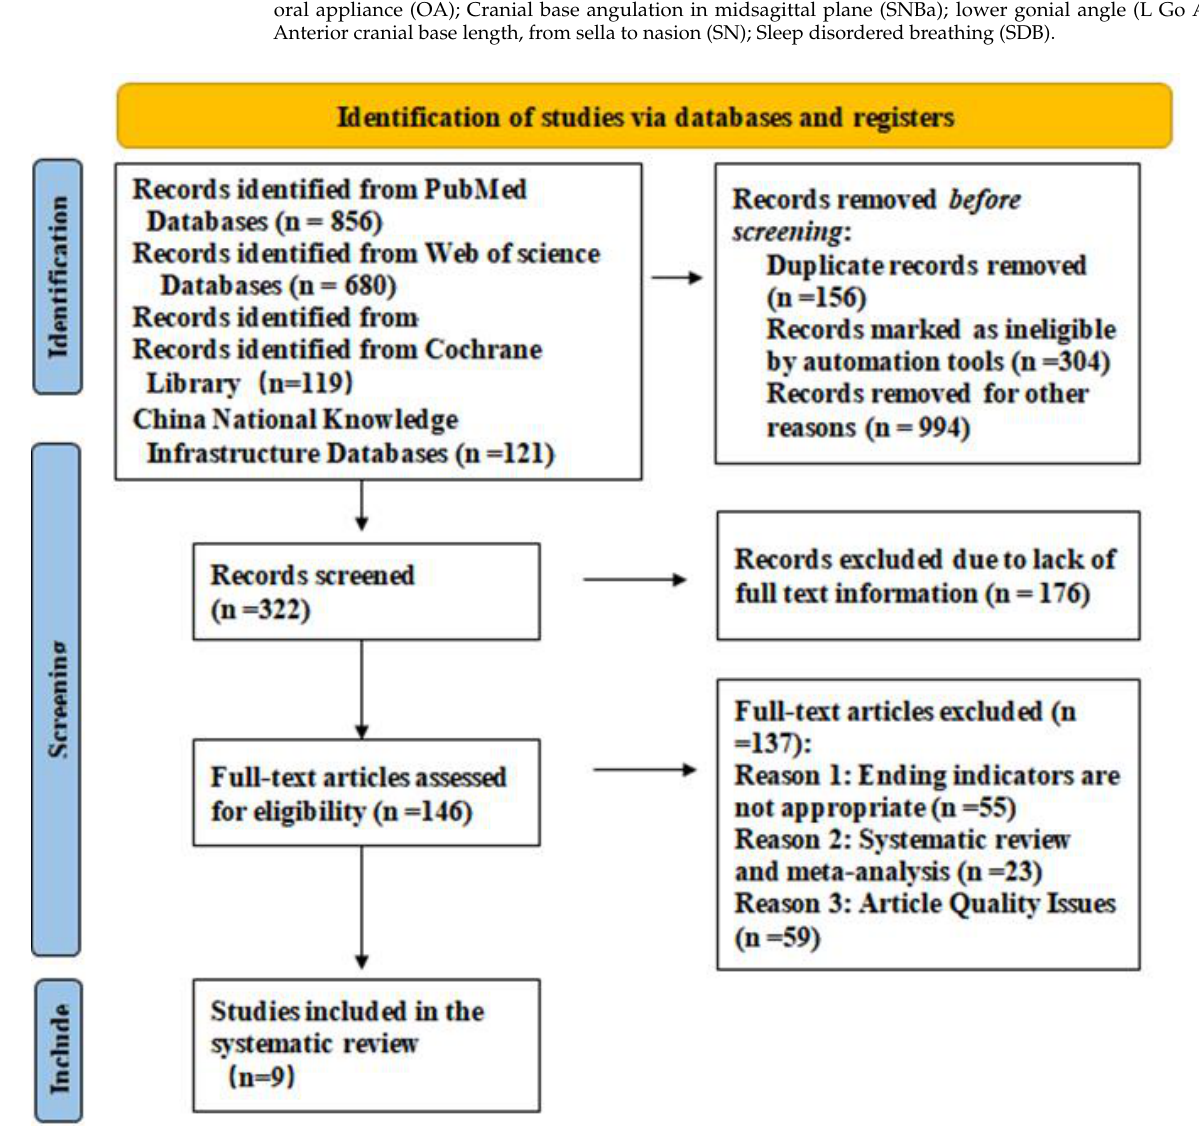
Figure 1. PRISMA 2020 flow diagram.